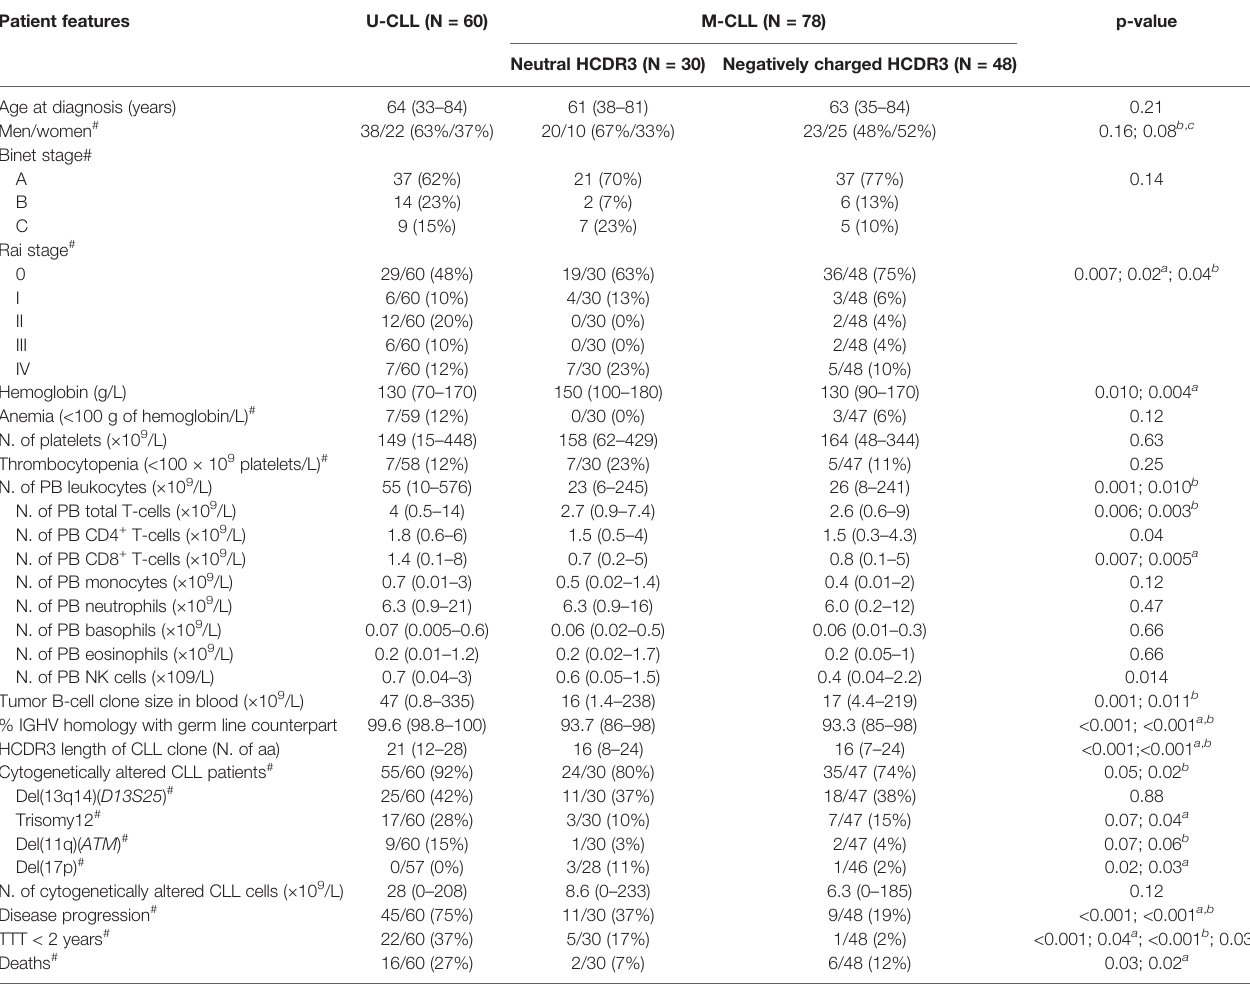
TABLE 2 | Clinical and biological features of CLL patients classi fi ed according to their IGHV mutational status and the HCDR3 hydropathy index. Patient